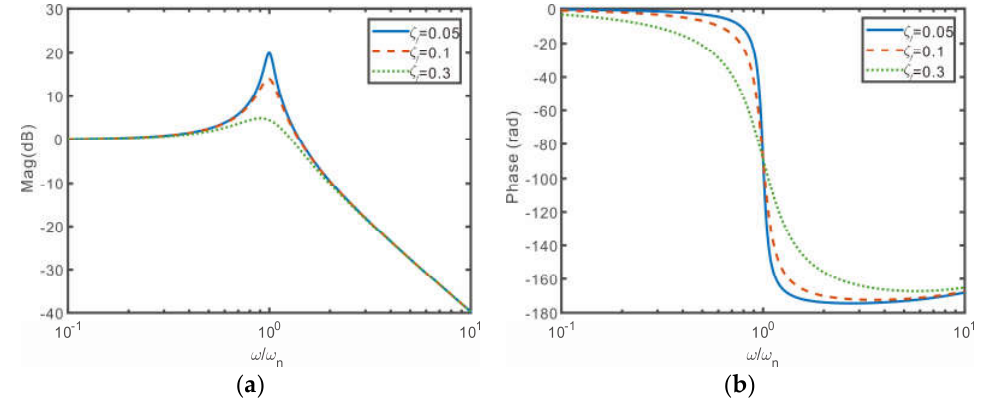
Figure 2. Bode diagram for the proposed compensator. ( a ) Magnitude; ( b )